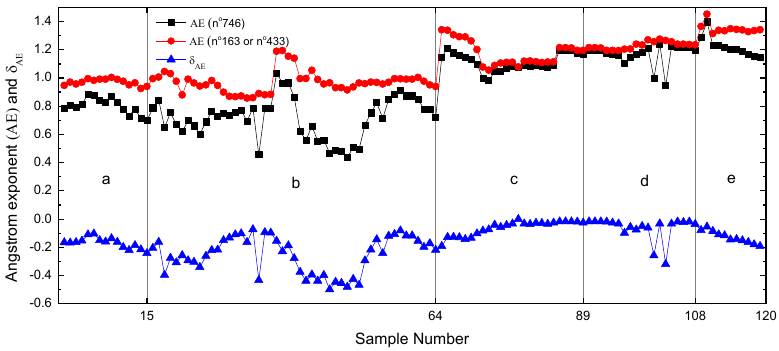
Figure 9. Simultaneously measured AE and AE differences between the reference instrument and the experiment instruments under the effects of five factors: ( a ) spider web inside the collimator, ( b ) collimator bending, ( c ) dust inside the optical head, ( d ) incrustation scale inside the optical head, and ( e ) dust and incrustation scale inside the optical head.